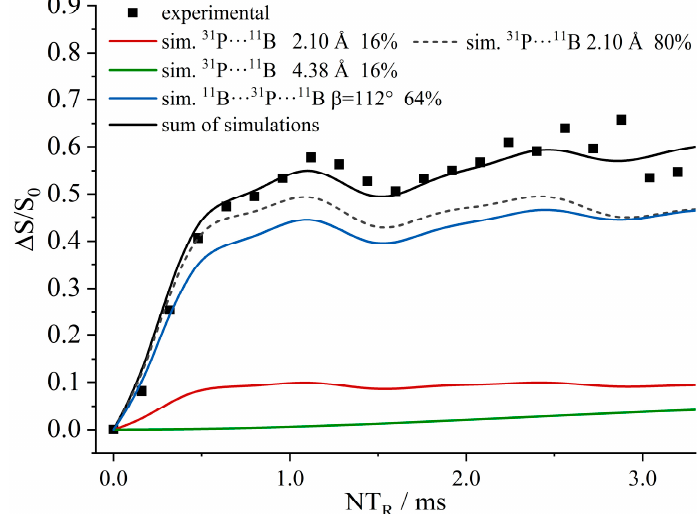
Figure 23. Experimental and simulated 31 P{ 11 B} REAPDOR curves obtained for 5 . Corresponding simulations based on the single-crystal structure are included as solid lines. The simulated curve is the weighted sum of the individual curves obtained for the three possible isotopologues: a three-spin 11 B ... 31 P ... 11 B system with distances of 2.10 and 4.38 Å (64.2%, red curve) and a B ... P ... B angle of 112 ◦ and two 11 B ... 31 P two-spin systems with distances of 2.10 and 4.38 Å (blue and green curves). The dashed curve is an approximate two-spin simulation, neglecting the secondary 4.38 Å distance.